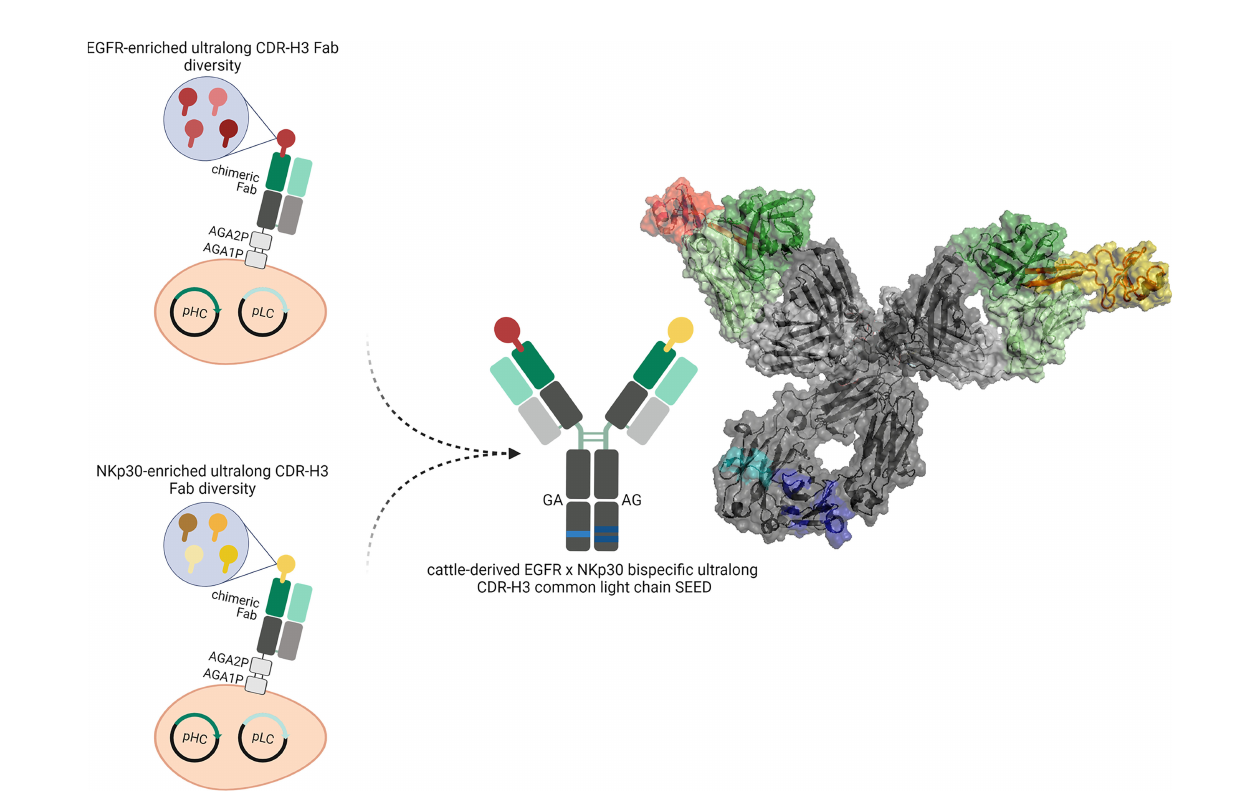
FIGURE 1 | Overview about the generation of cattle-derived ultralong CDR-H3 common light chain bispeci fi c antibodies. After immunization of cattle and library generation antigen-speci fi c paratopes are enriched against both targets (shown in red color and yellow color). To this end, ultralong CDR-H3 regions encoding for stalk/knob architectures are speci fi cally ampli fi ed and grafted onto a fi xed chimeric Fab scaffold utilizing a single light chain. After selection, common light chain paratopes are reformatted into an IgG-like bispeci fi c format exploiting a heavy chain heterodimerization technique (e.g. the SEED technology). Schemes generated using biorender (www.biorender.com). Model constructed with PYMOL v0.99 based on pdb entries 5dk3 and 5ilt. Individual paratopes based on stalk/knob structures are colored in red and yellow, respectively. Fixed VH region based on IGHV1-7 shown in dark green, utilized VL30 exploited as common light chain shown in light green. Constant regions of the heavy chains colored in dark grey, CL l shown in light grey. Use of heavy chain heterodimerization technology resulting in two distinct heavy chains indicated by the use of dark blue and light blue